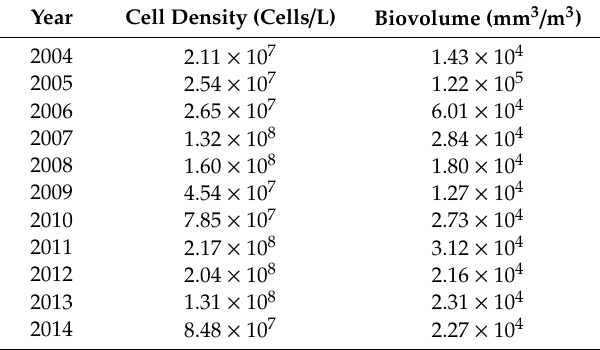
Table A1. Total phytoplankton community expressed as cell density (cells / L) and biovolume (mm 3 / m 3 ) for the period 2004–2014.